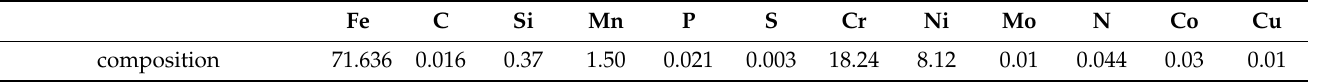
Table 1. Mill test certificate